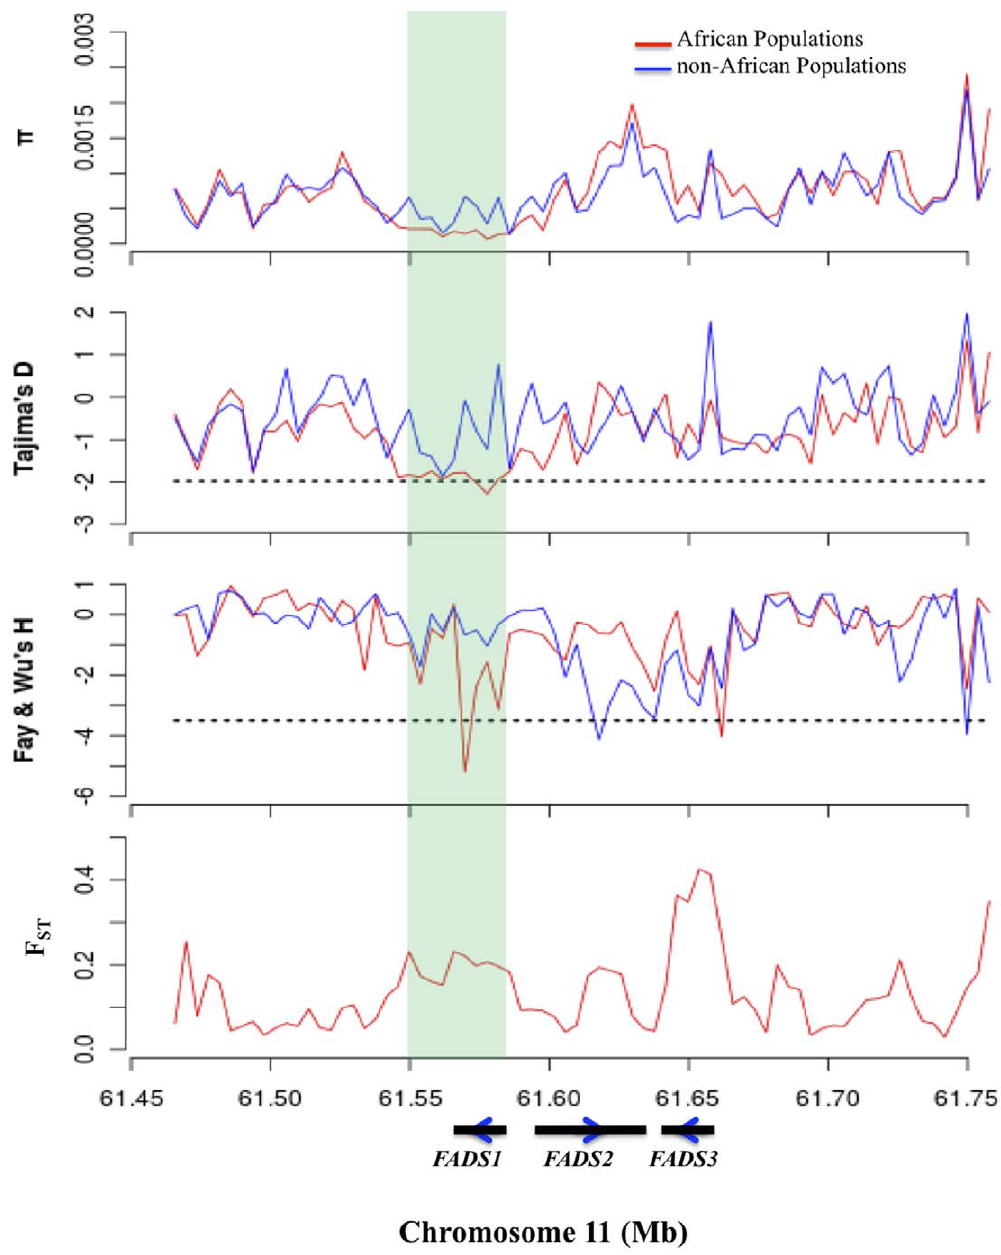
Figure 2. Summary of sliding window analysis across a 300 kb region (chr11:61467097–61759006, hg19) centered on the FADS gene cluster for two African (YRI and LWK) versus eight non-African populations (IBS, CEU, GBR, FIN, TSI, JPT, CHB and CHS). Genetic diversity p , Tajima’s D, Fay & Wu’s H, and pairwise F ST were calculated using a window size of 5 kb and an overlap of 1 kb. The teal shaded box represents the , 30 kb haplotype block noted within the African samples and the three black bars represent FADS1, FADS2 and FADS3 from left to right, respectively along with direction of transcription. Dotted lines represent the threshold for an empirical P=0.01 comparing across all windows in the genome for Tajima’s D, Fay & Wu’s